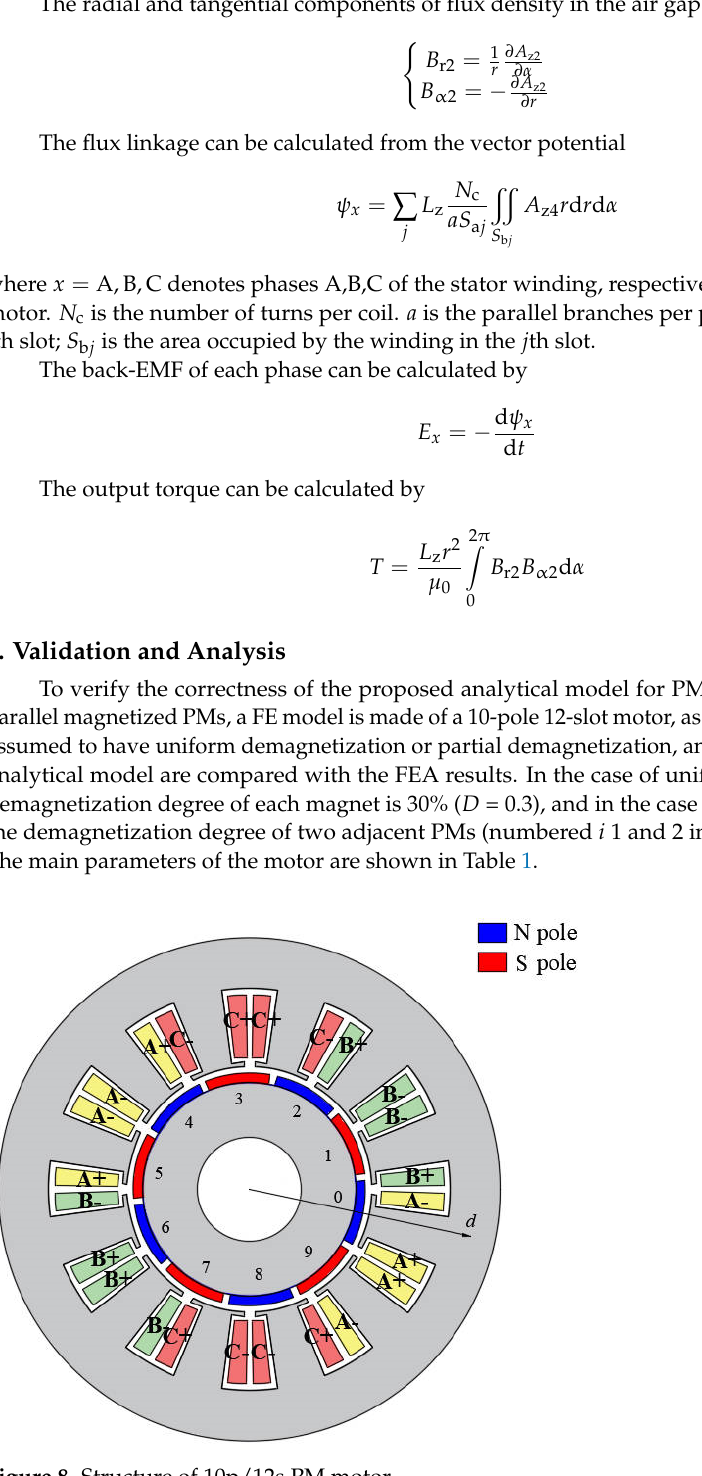
Figure 8. Structure of 10p/12s PM motor.